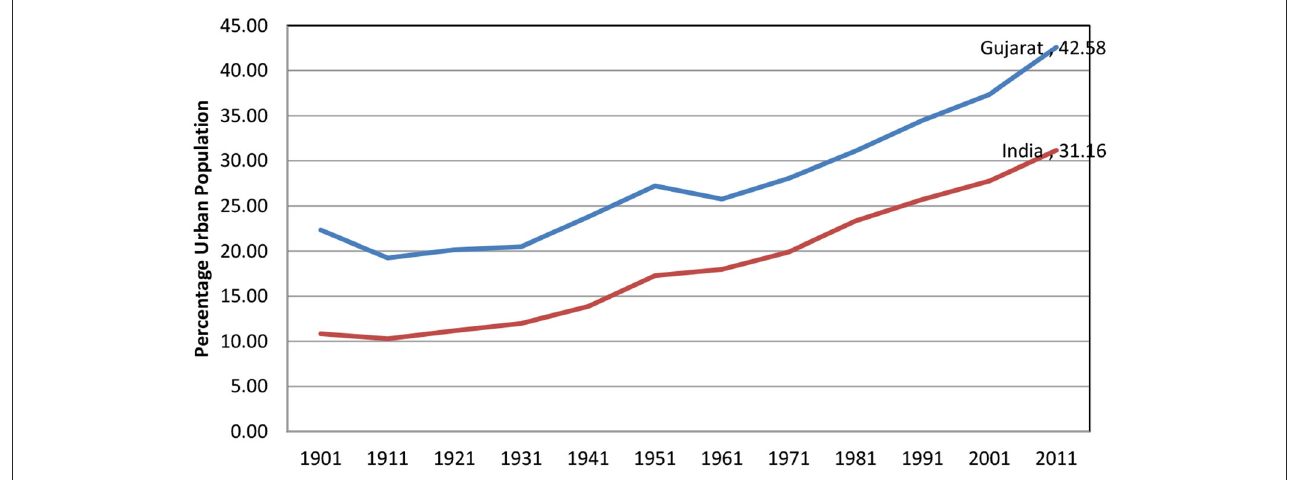
FIGURE1 Levels of Urbanization in Gujarat-1901 to 2011. Source: Computed from Census of India respective years from 1901 to 2011.